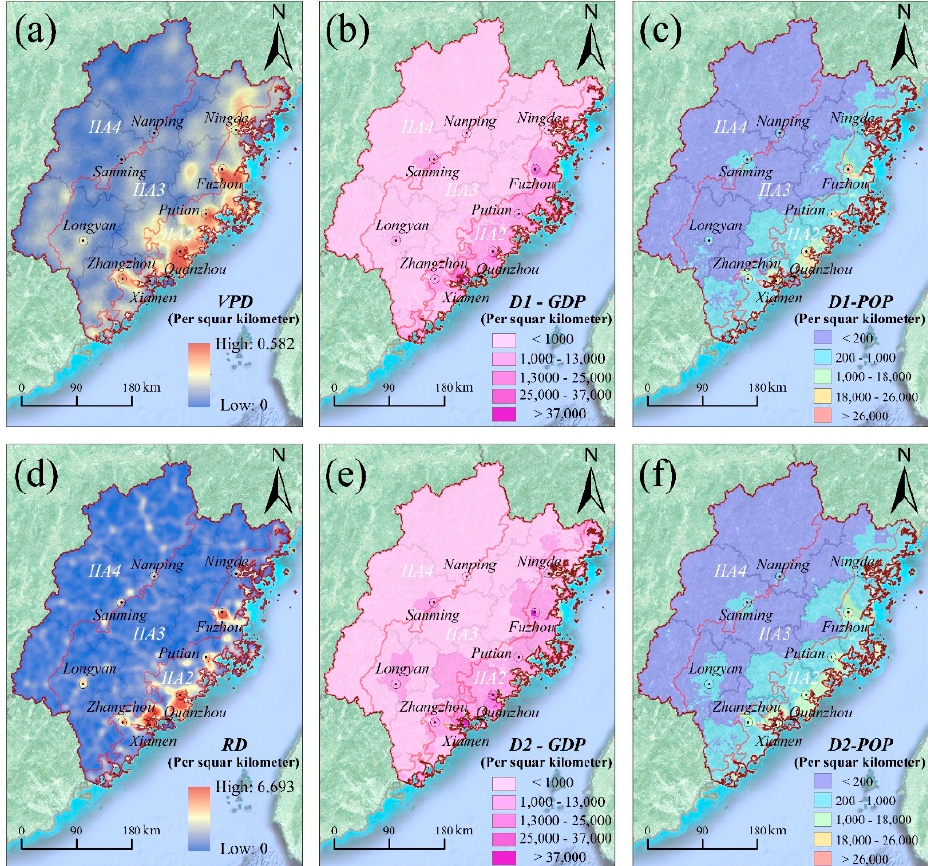
Figure 5. ( a ) VPD and ( d ) RD display the spatial distribution of the VPD and RD, respectively; ( b ) and ( c ) present the spatial distributions of GDP and POP in D1, respectively; ( e ) and ( f ) exhibit the spatial distributions of GDP and POP in the D2 period, respectively.